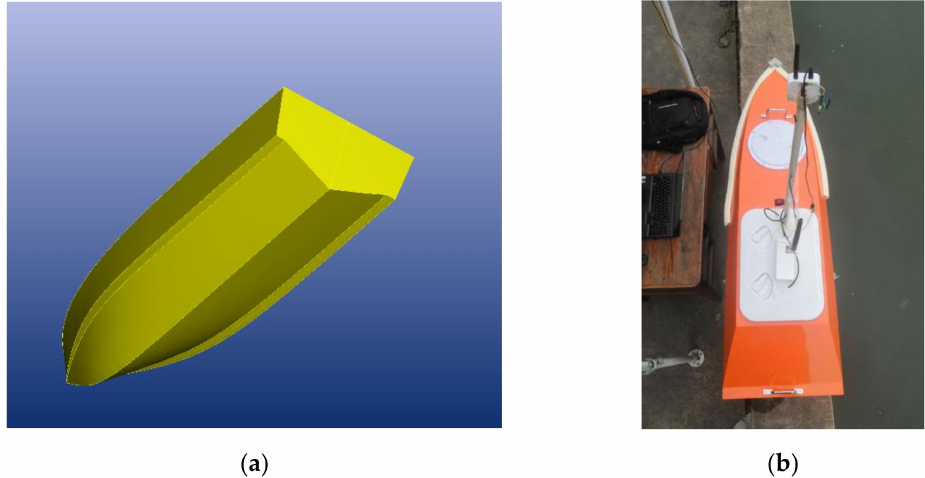
Figure 2. Geometric model and physical model of the USV ( a ) geometric shape ( b ) model of the USV. Table 1. Main scale of the unmanned